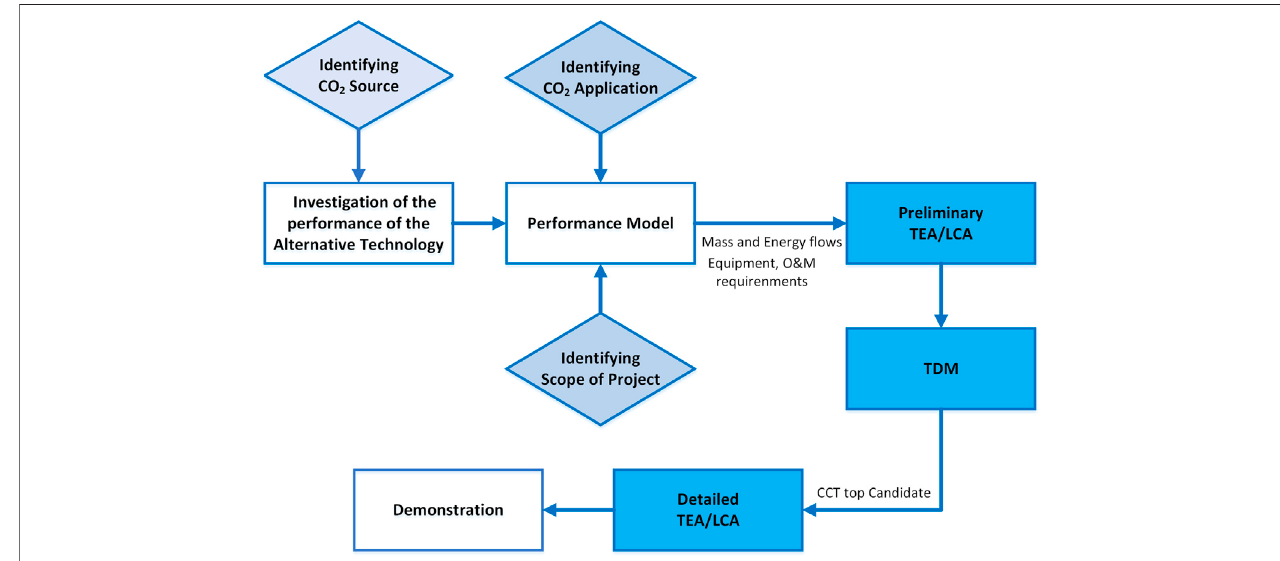
FIGURE 4 | TDM linkage to TEA and LCA. Overall framework for preliminary screening and fi nal CCT benchmarking.